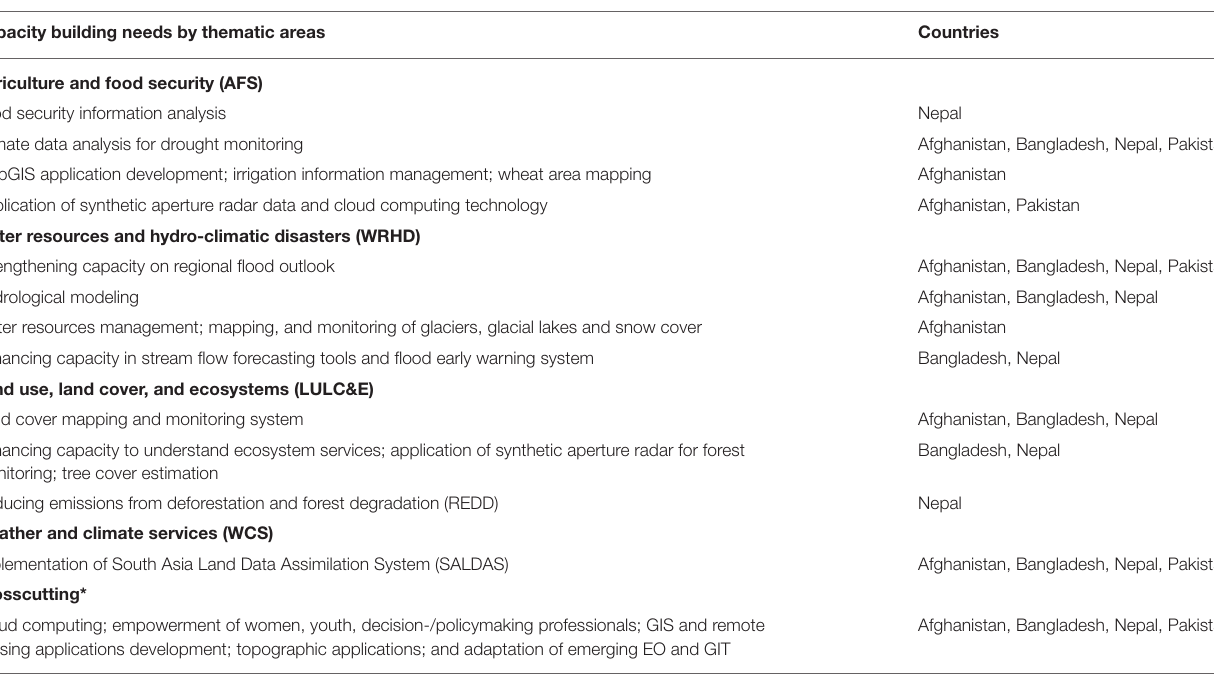
TABLE 2 | Capacity building needs and priorities in the four